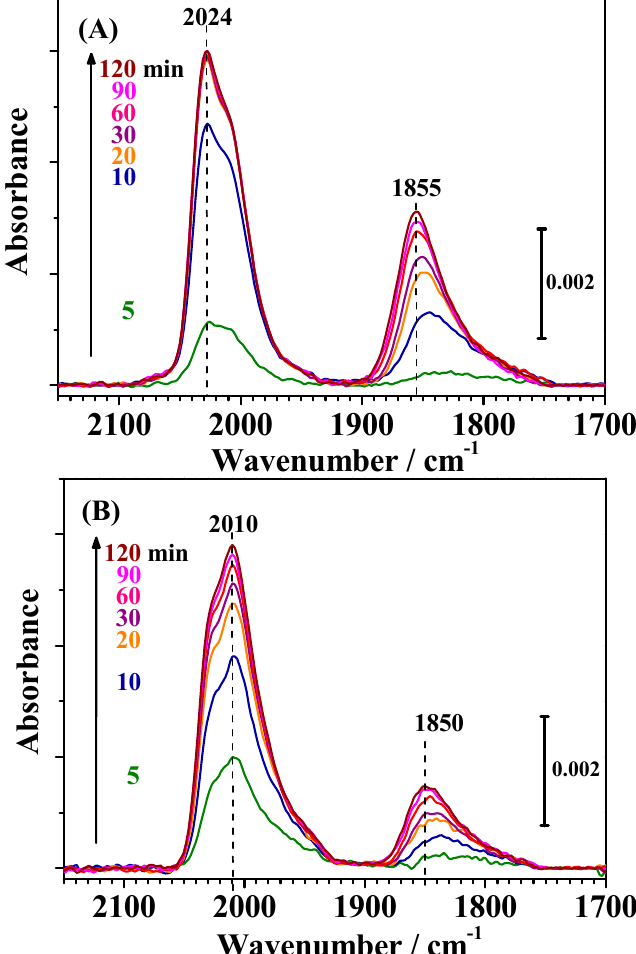
Figure 4. Changes in FTIR spectra observed on Nafion ‐ coated ( A ) Pt 2AL –PtFe/C and ( B ) c ‐ Pt 2 Ru 3 /C electrodes at 0.02 V and 60 °C during CO adsorption in 0.1 M HClO 4 with bubbling 1% CO (H 2 balance) for 120 min.